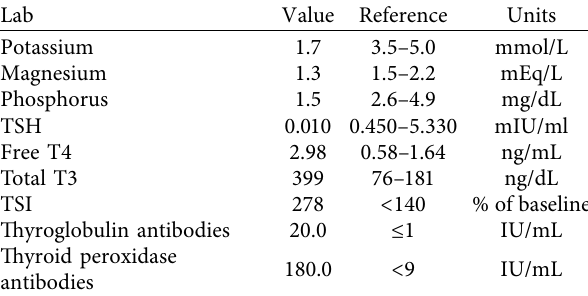
Table 1: Initial laboratory